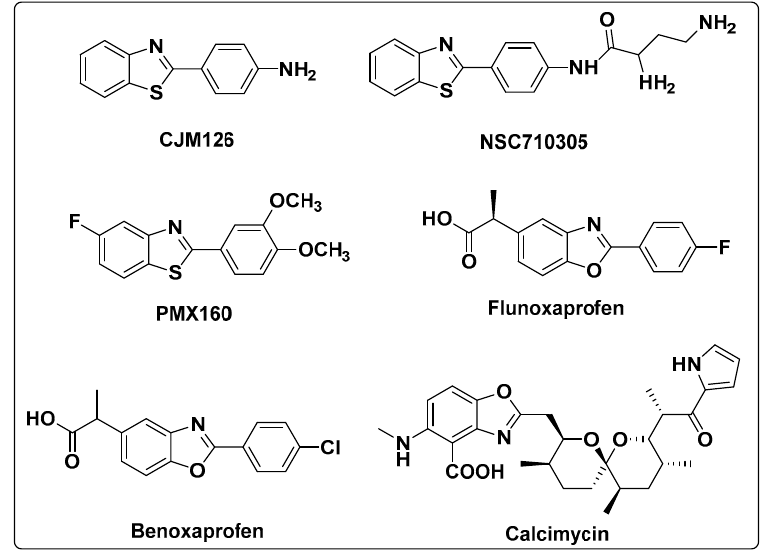
Figure 1. Chemical structures of some drugs bearing benzoxazole and benzothiazole scaffolds.